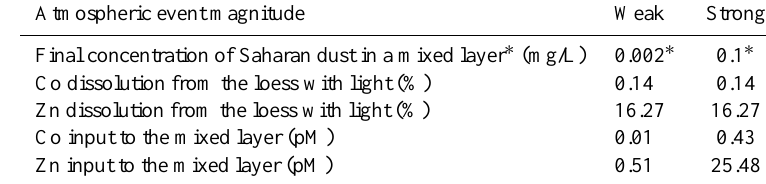
Table 5. Dissolved Co and Zn inputs to a mixed layer (50m) induced by a weak and a strong atmospheric event and estimated with the percentage of dissolved metal from the dust after 2h of dissolution in